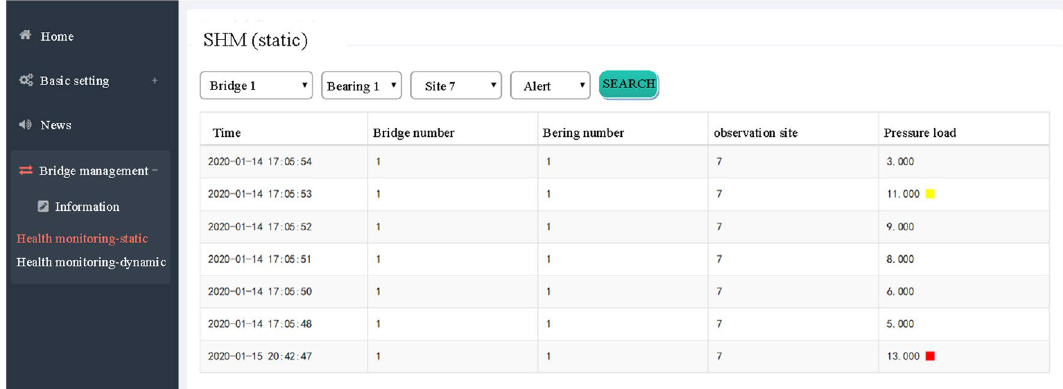
Figure 21. Bridge health monitoring static display